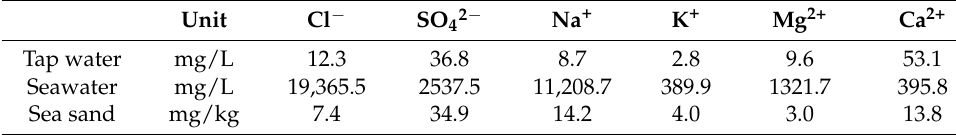
Table 1. Chemical composition of tap water, seawater, and sea sand. Unit Cl −